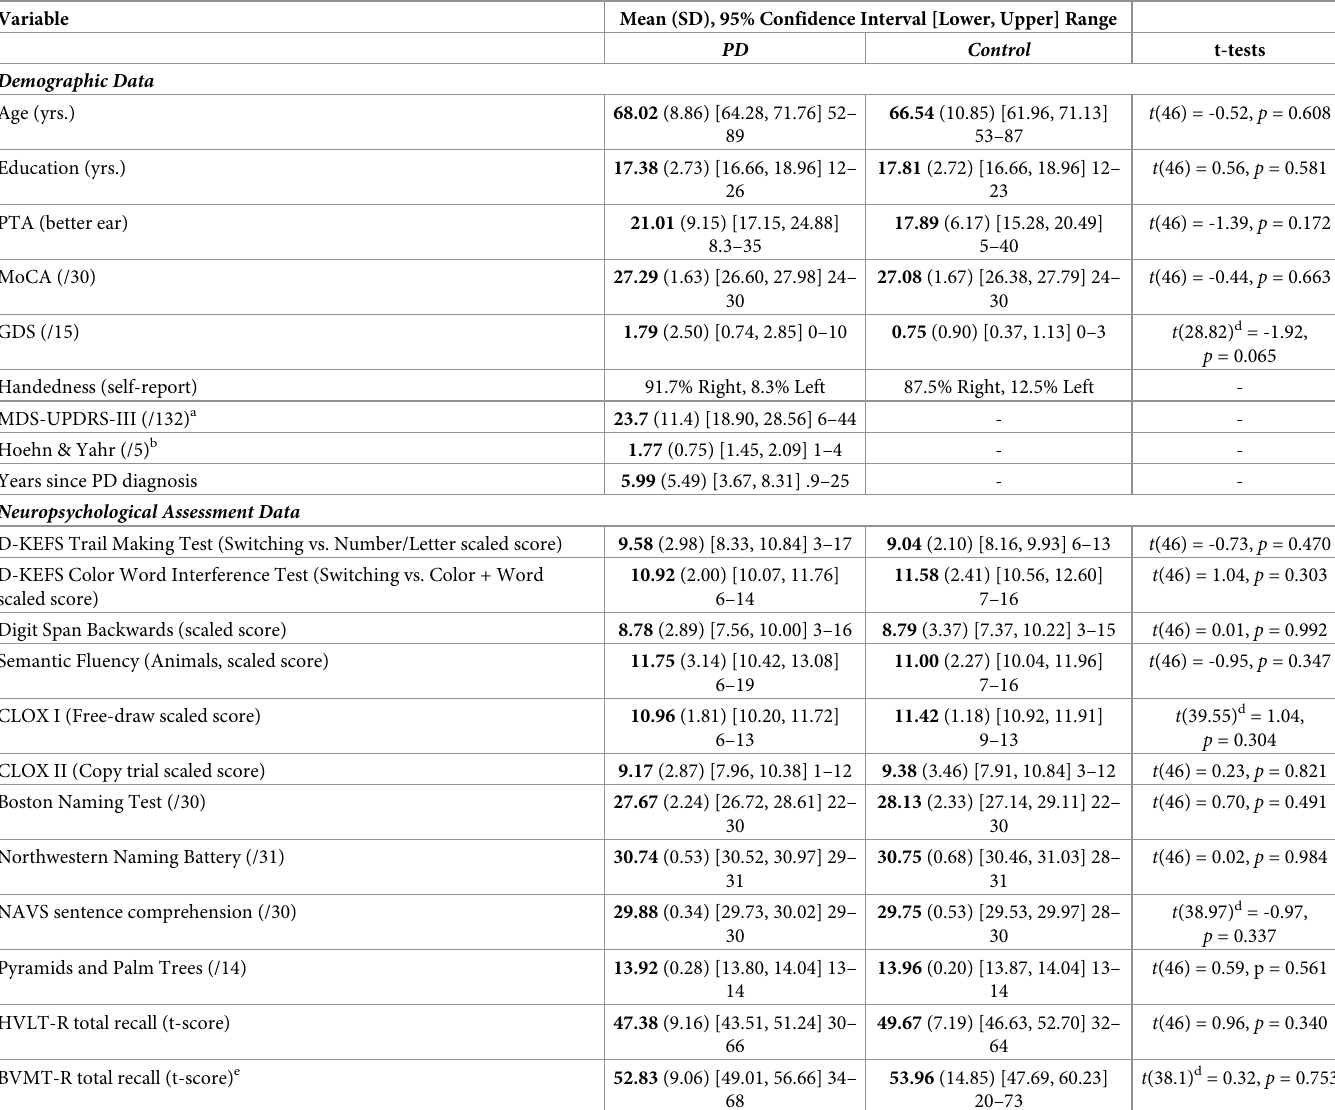
Table 1. Participant demographic and neuropsychological data by